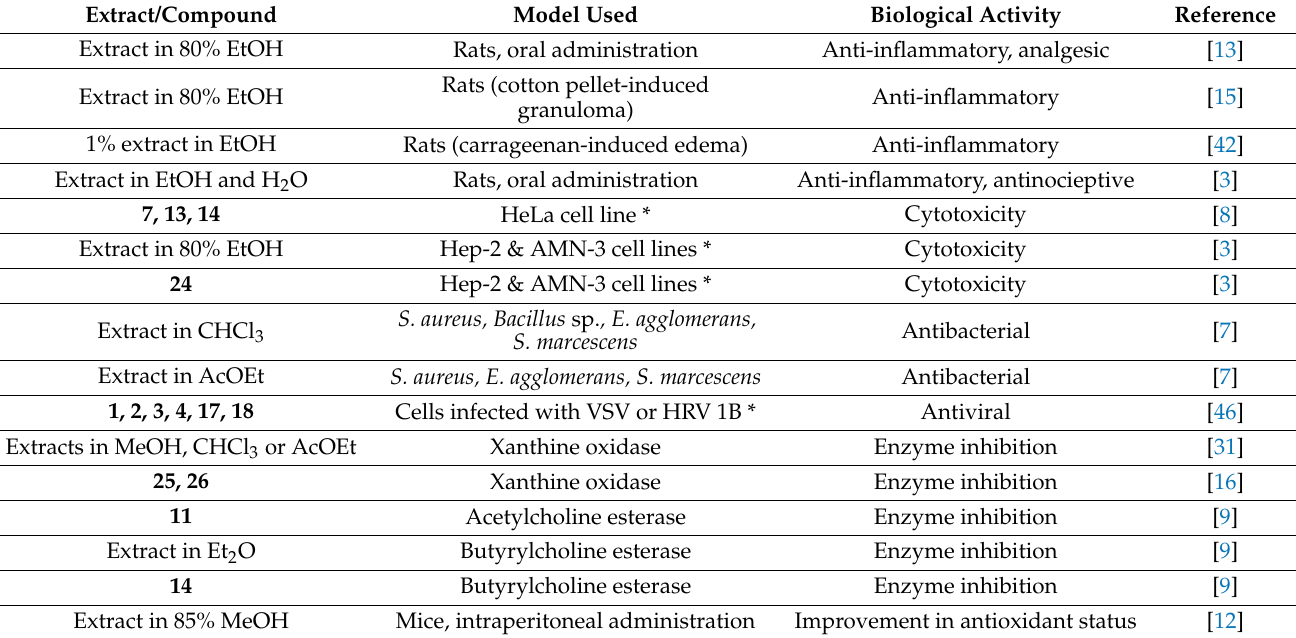
Table 3. Biological activity of Tamus communis rhizome extracts and some of individual phytochemicals.